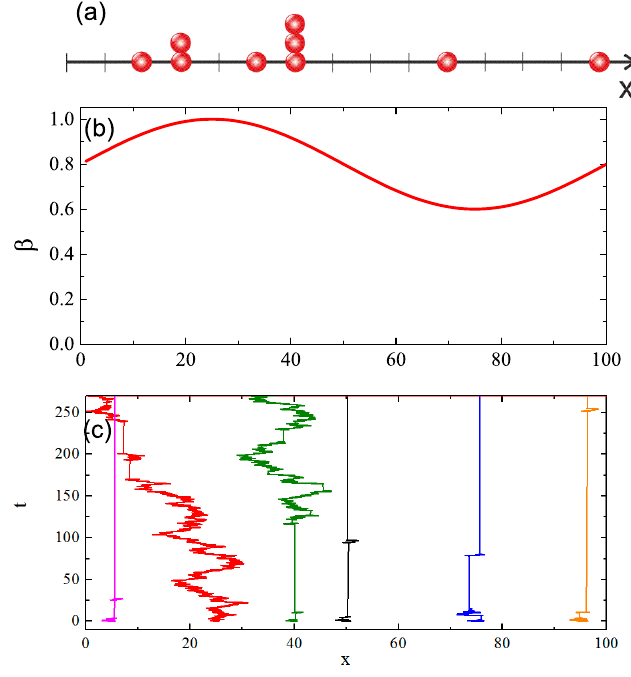
Figure 12. Independent CTRW walkers on a line ( a ). Spatial modulation of parameter β = β ( x ) of Mittag-Leffler distribution of waiting times ( b ). Exemplary trajectories for a few walkers performing CTRW with α = 2 and β = β ( x ) ( c ).